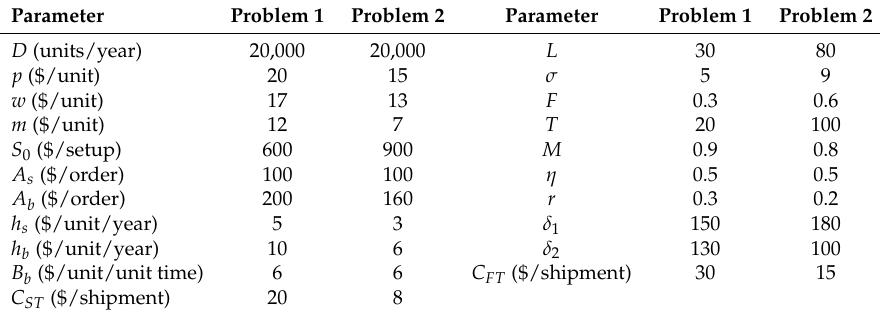
Table 1. Input data for numerical example.